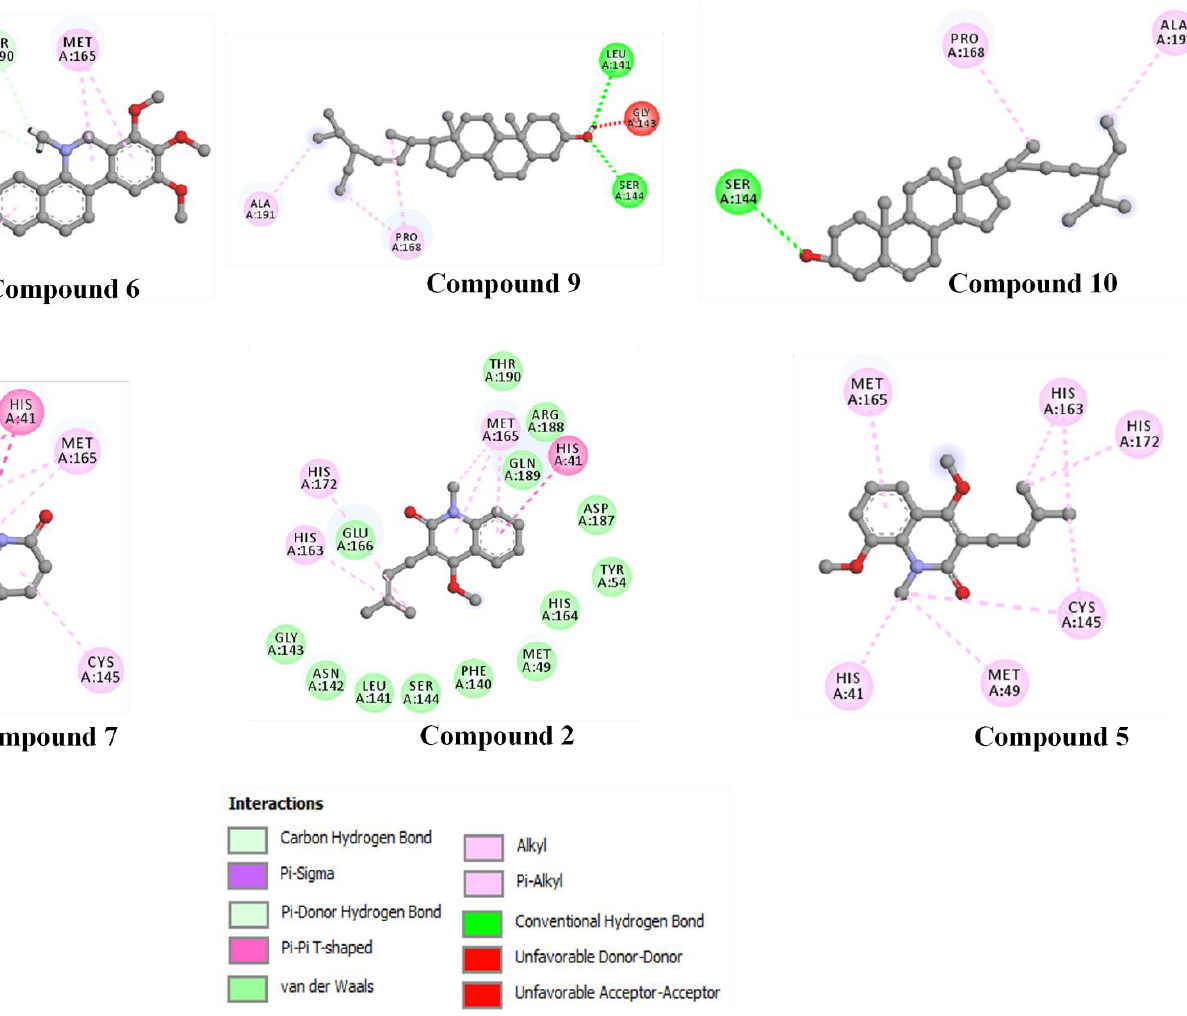
Figure 5. Non-bonding interactions of different compounds with Mpro (Pose predicted by Auto- Dock Vina).